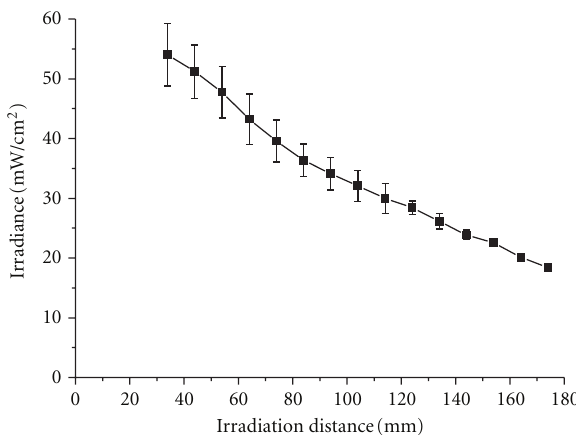
Figure 3: Irradiance as a function of the irradiation distance.